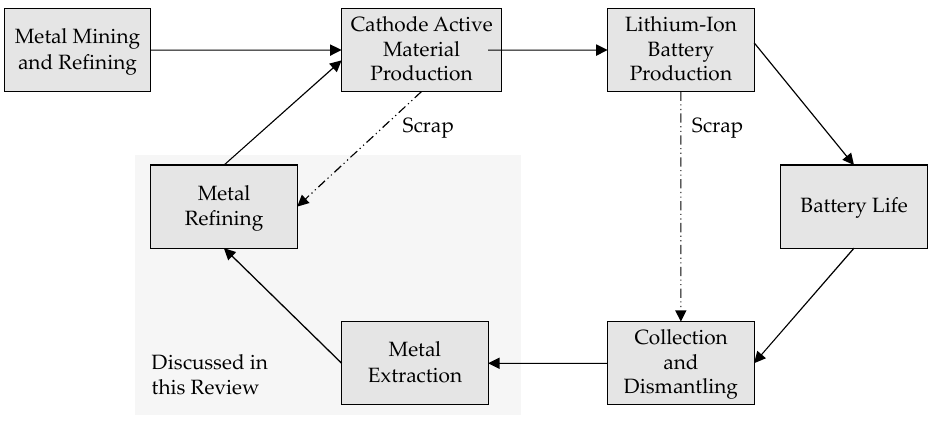
Figure 1. Closed loop for battery materials.